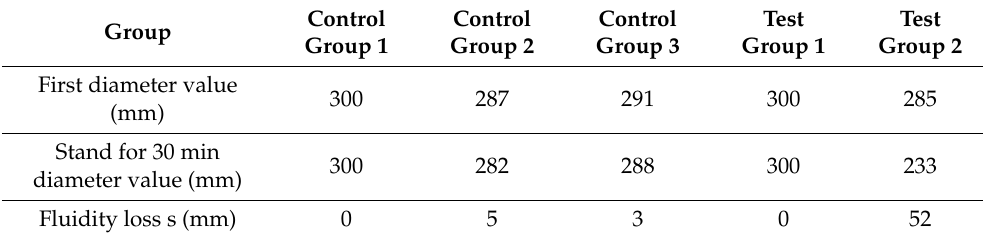
Table 8. Fluidity test results of Embodiment